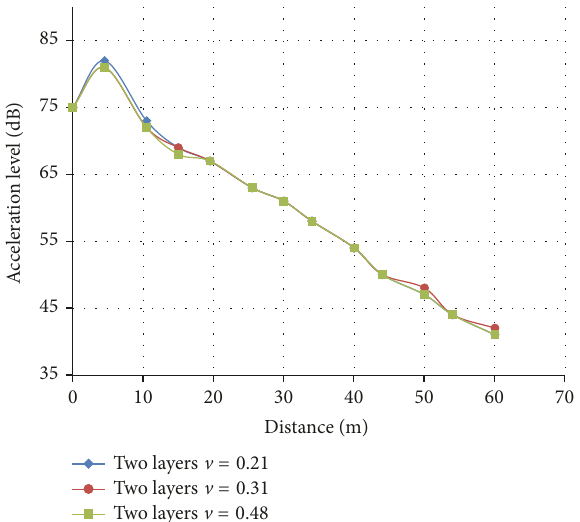
Figure 18: The comparison of acceleration level among cases 1 , 2 , and 3 in scheme 1